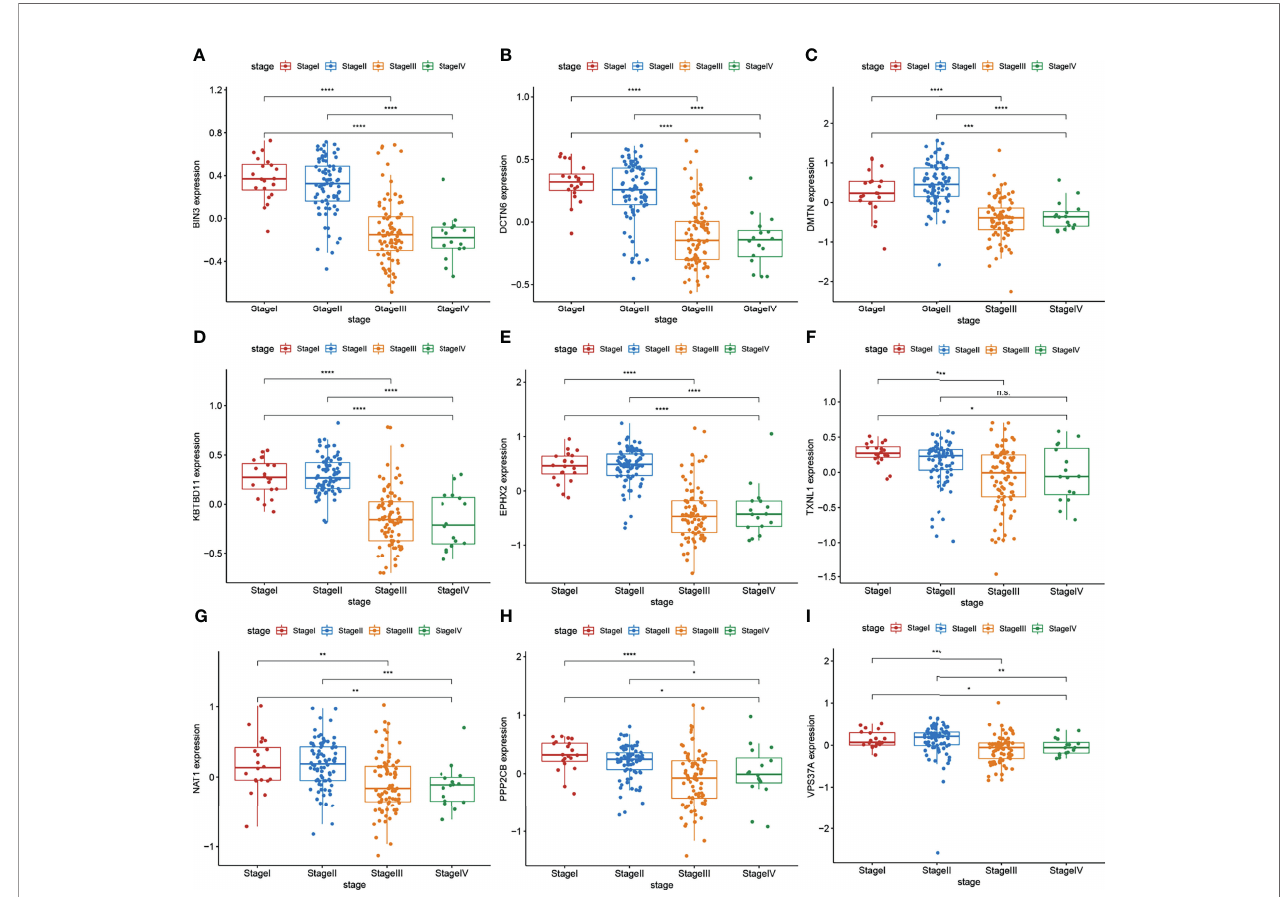
FIGURE 2 | (A – I) Protein expression levels of target genes (BIN3, DCTN6, DMTN, KBTBD11, EPHX2, TXNL1, ANAT1, PPP2CB, and VPS37A) were negatively correlated with the TNM stage of CRC (n = 297 (stage I: 28, stage II: 120, stage III: 125, stage IV: 24). Wilcoxon ’ s test was used to compare groups. n.s, not signi fi cant; *p < 0.05,**p < 0.01,***p < 0.001,****p <